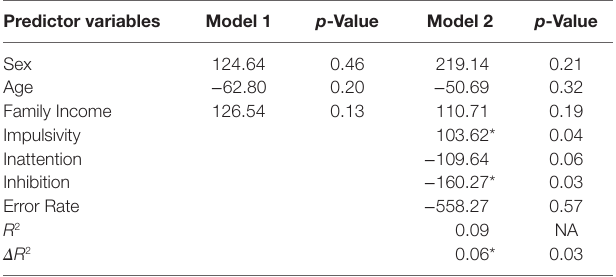
Table 7 | Sequential regression analysis of predictors of mathematics scores.